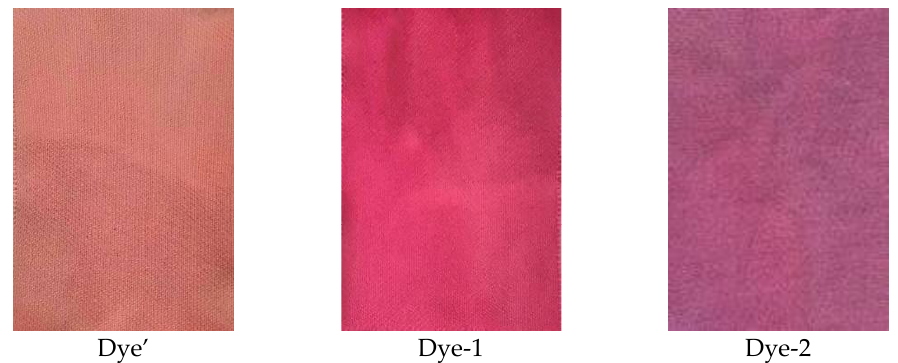
Figure 4. Digital pictures of the cotton knitted fabrics dyed with the synthesized dyes.